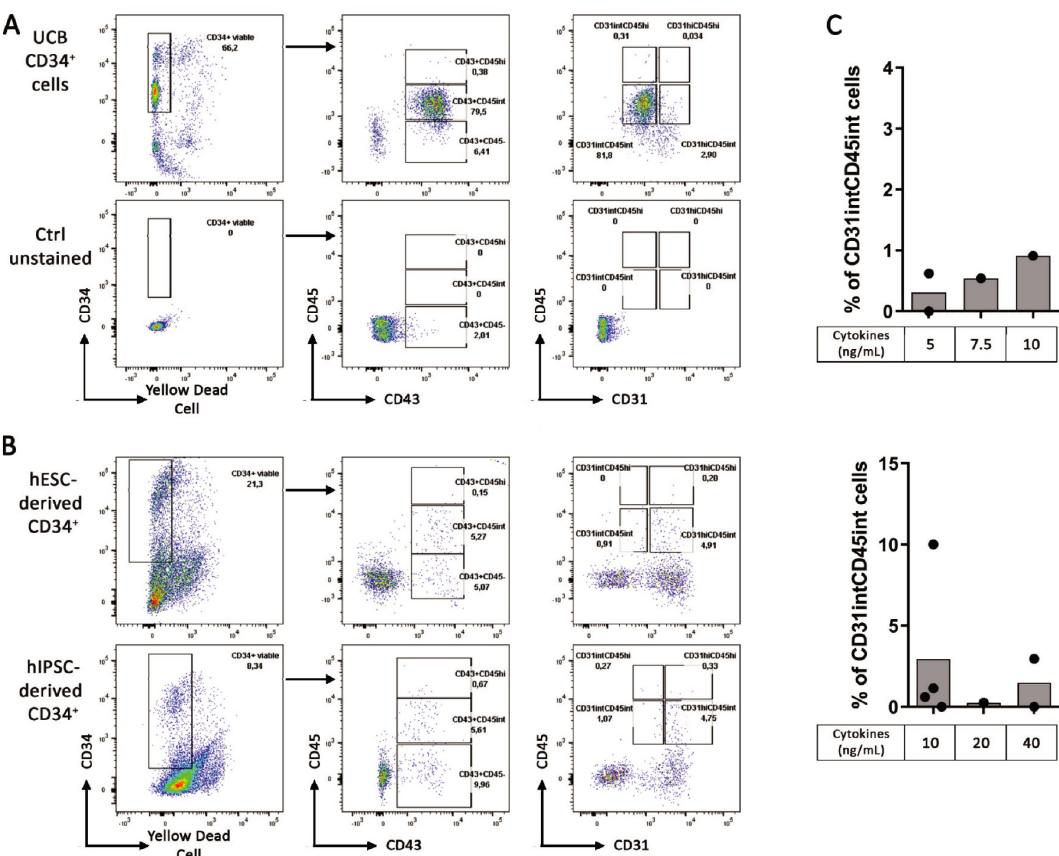
Fig 6. CD31 int CD45 int are important progenitors for B cells differentiation. Characterization of CD34 + progenitors by their expression analysis of the following markers CD45, CD43 and CD31. FACS analysis was performed from (A) UCB CD34 + cells (Upper panel) with unstained cells as control (lower panel), dot plot representative of 2 experiments and from (B) hESC-derived CD34 + (Upper panel) and hIPSC-derived CD34 + (lower panel) using our CD34 + differentiation protocol with cytokines at 10ng/ml, dot plot representative of 2 experiments for hESC and 4 experiments for hIPSC. (C) Histograms show CD31 int CD45 int proportion in hESC (upper panel) and hIPSC (lower panel) at Day 10 of CD34 + using our CD34 + differentiation protocol with cytokines at different concentrations (n = 1 to 4 independent